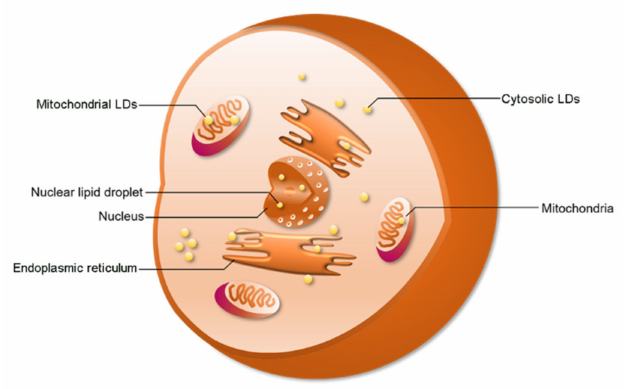
Figure 1. The distribution of lipid droplets (LDs). LDs have been found in the cytosol, nucleus, and mitochondria. Cytosolic LDs account for a large proportion of total